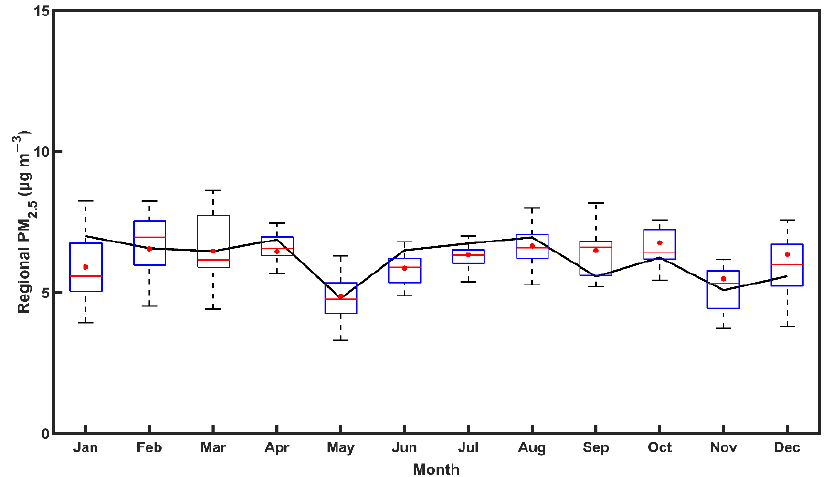
Figure 7. Monthly averaged regional background PM 2.5 concentrations for the city of Patras during the study period (2017–2019). The solid black line represents the background concentrations calcu- lated as the average of the measurements in the two background stations (Platani and University of Patras). The bottom and top edges of the blue boxes indicate the 25th and 75th percentiles of the back- ground PM 2.5 values for the various stations calculated using the Diamantopoulou et al. [34] method, the red dots show the average concentrations, and the red lines show the median concen- trations.